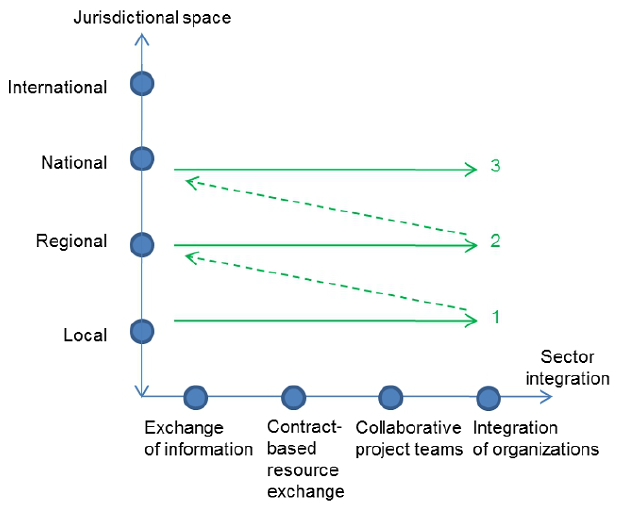
Fig. 5 . Sector integration set against jurisdictional